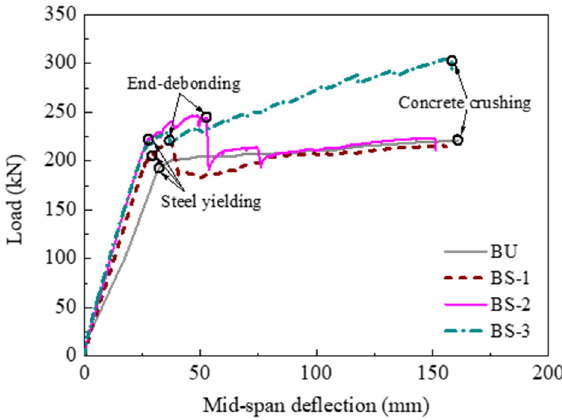
Figure 8. Influence of the anchorage method.